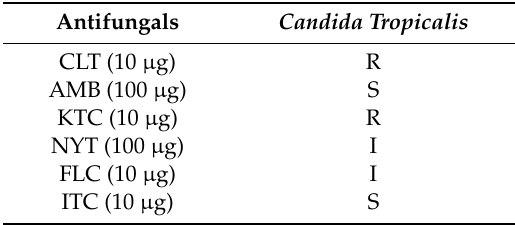
Antifungal susceptibility pattern of Candida tropicalis (S—Sensitive, I—Intermediate, R—Resistance).